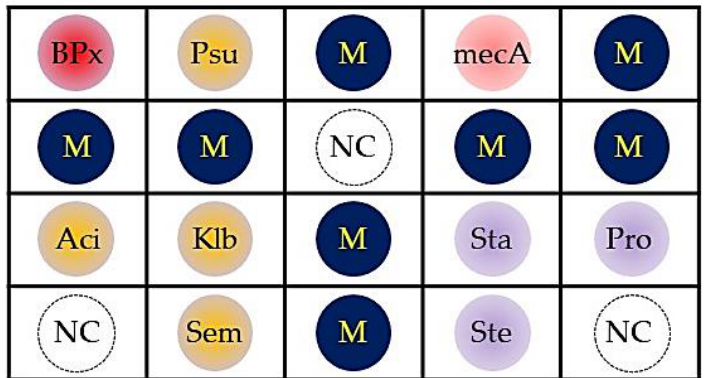
Figure 1. A schematic dot hybridization model for detecting a putative core ocular surface microbiota. The postulated core ocular surface microbiota (detecting dot) included Pseudomonas aeruginosa (Psu), Acinetobacter baumannii (Aci), Klebsiella pneumoniae (Klb), Serratia marcescens (Sem), Staphylococcus aureus (Sta), Staphylococcus epidermidis (Ste), and Propionibacterium acnes (Pro). In addition, there was one dot for determining microbial burden (BPx) and another for surveilling antibiotic resistance of microorganism (mecA). M = marker; NC = negative control (tracking dye). Table 1. Oligonucleotide Probes Used in the Core Ocular Surface Microbiota Dot Hybridization Assay.